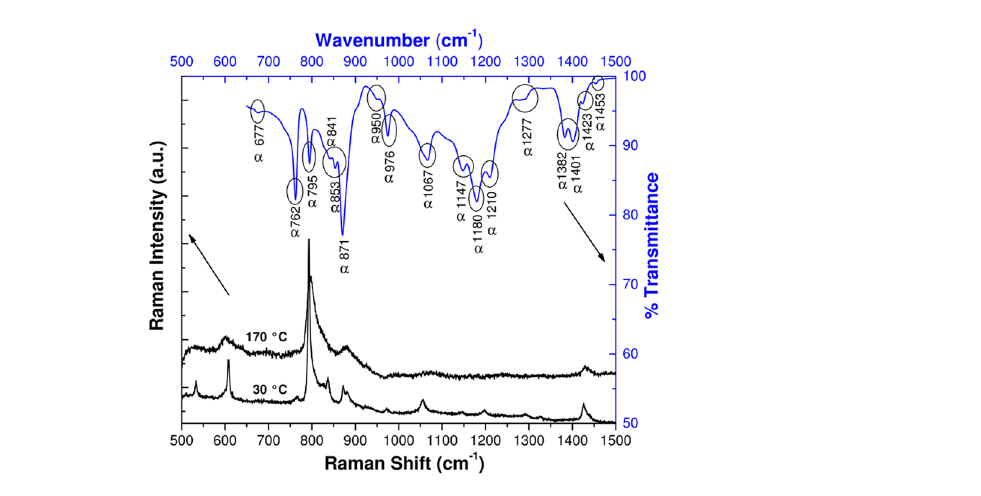
Figure 2. Raman spectra at 30 °C and 170 °C; FTIR spectrum of the membrane at 30